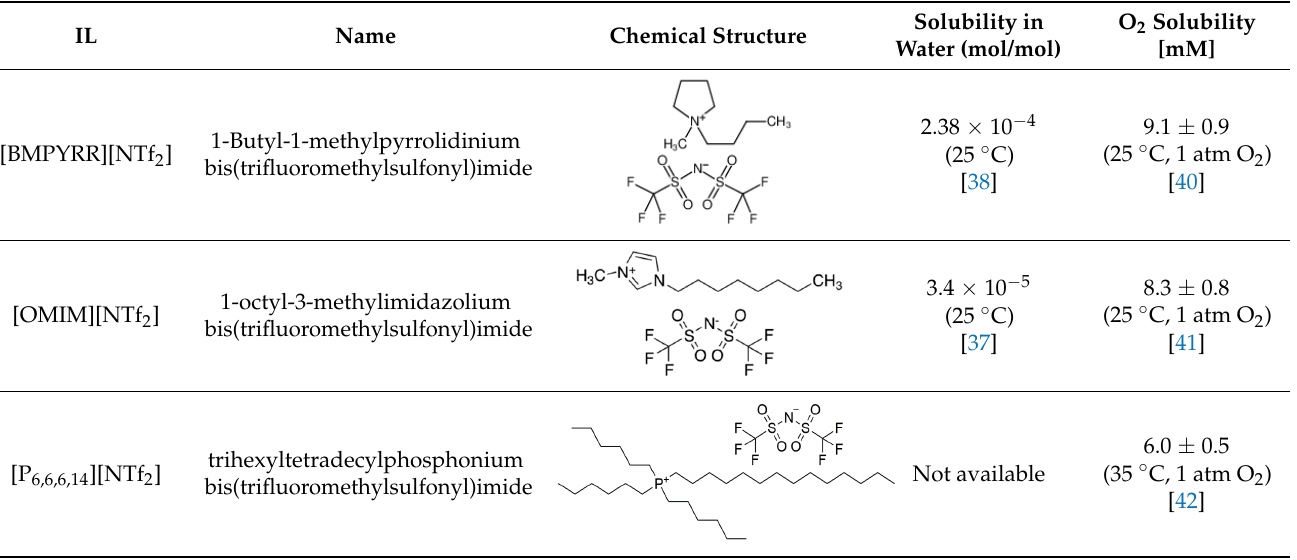
Table 1. Name, chemical structure, solubility in water, and oxygen solubility of the three ILs used in this